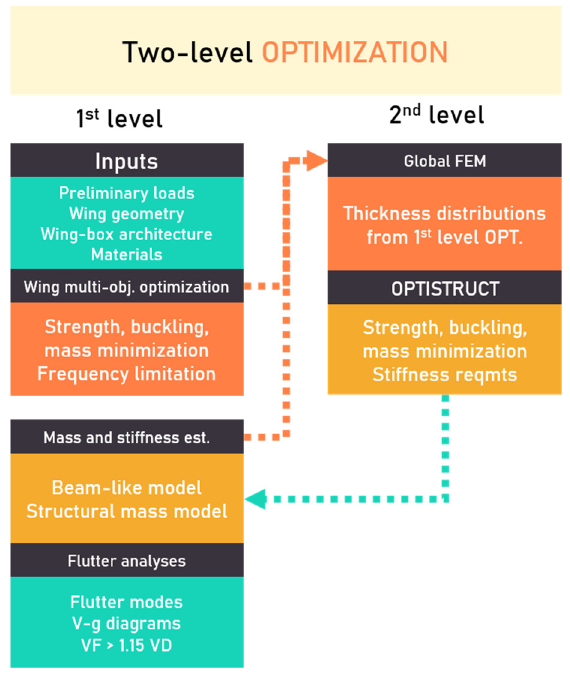
Figure 1. Design strategy flowchart.